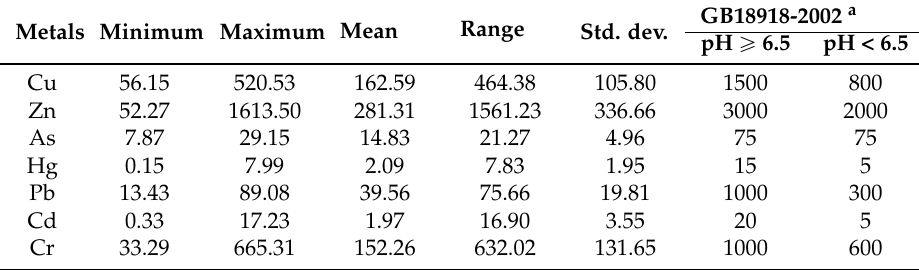
Table 3. Statistical analysis of heavy metal (HM) concentrations (mg/kg).